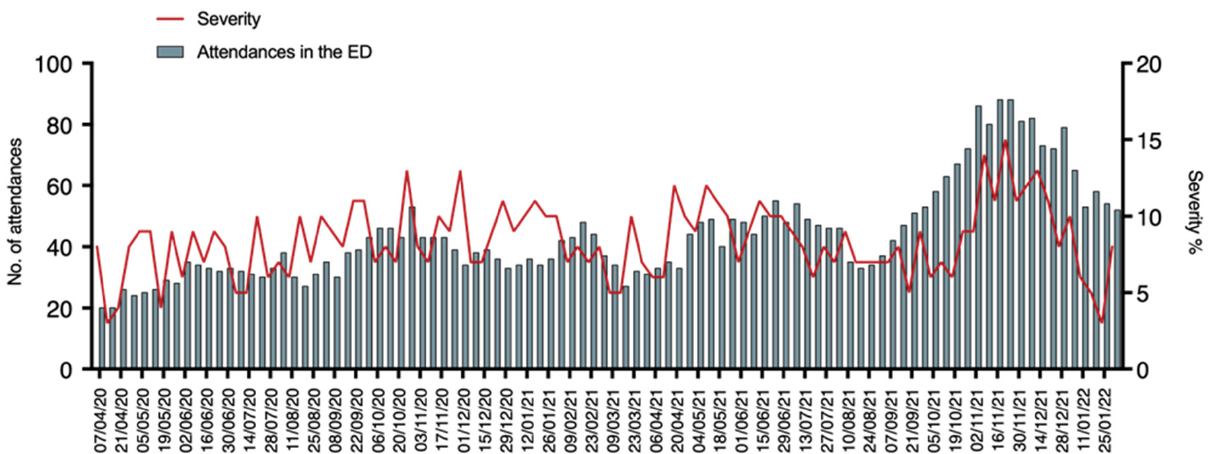
Figure 2. Red line represents the percentage of high urgency codes compared to the total number of accesses. Green columns represent the median number of daily attendances for each week.